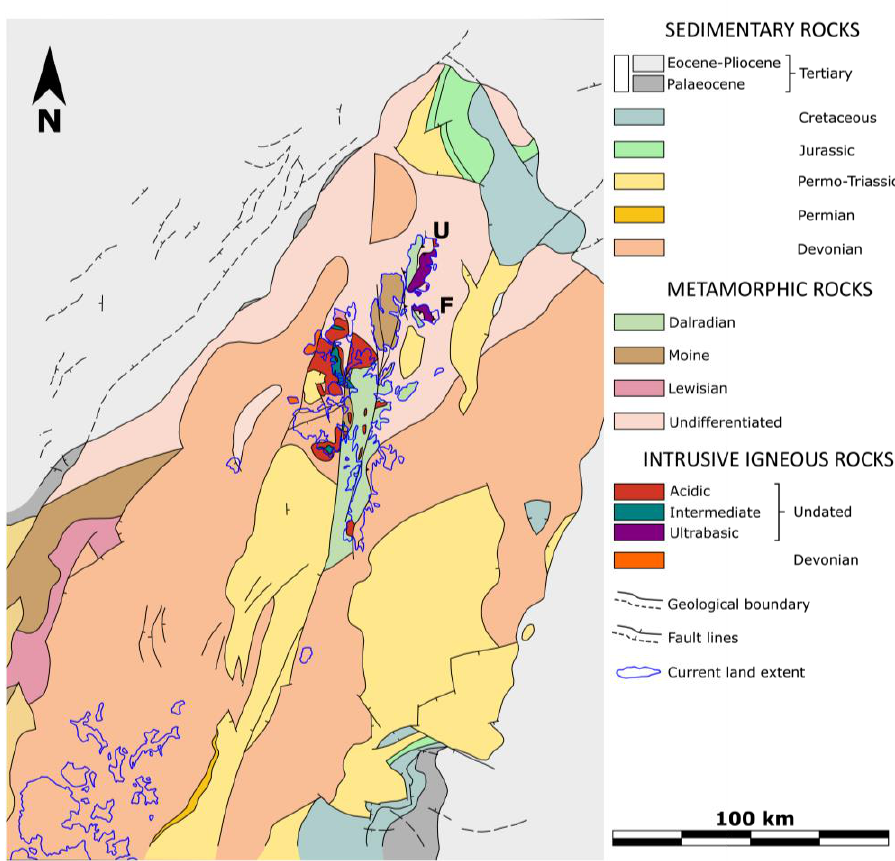
Figure 4. Simplified geological map of the hinterland (East Shetland Platform) and surrounding areas. Modified after Chesher [50]. U = Unst, F = Fetlar.